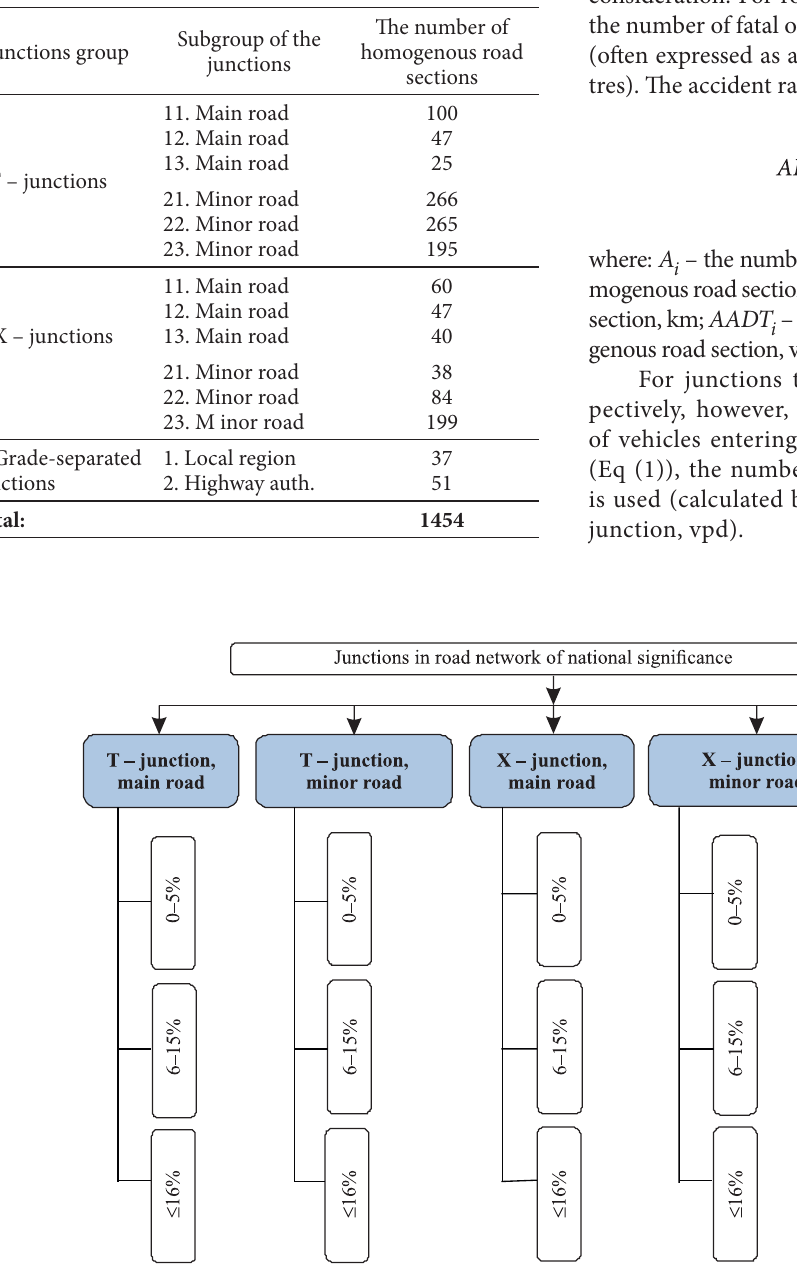
Fig. 2. The scheme on the division of junctions into groups and subgroups (a proportion of vehicles entering the junction from the minor road from the total amount of vehicles entering the